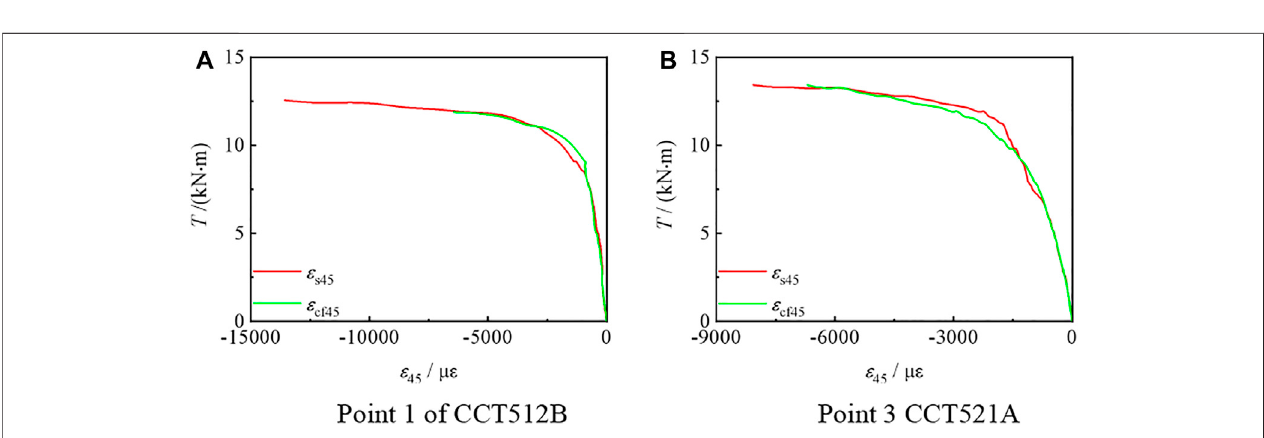
FIGURE 10 | T – ε 45 curve of the partial C-CF-CFRP-ST specimen. (A) 45 ° strain of steel tube and (B) CFRP.